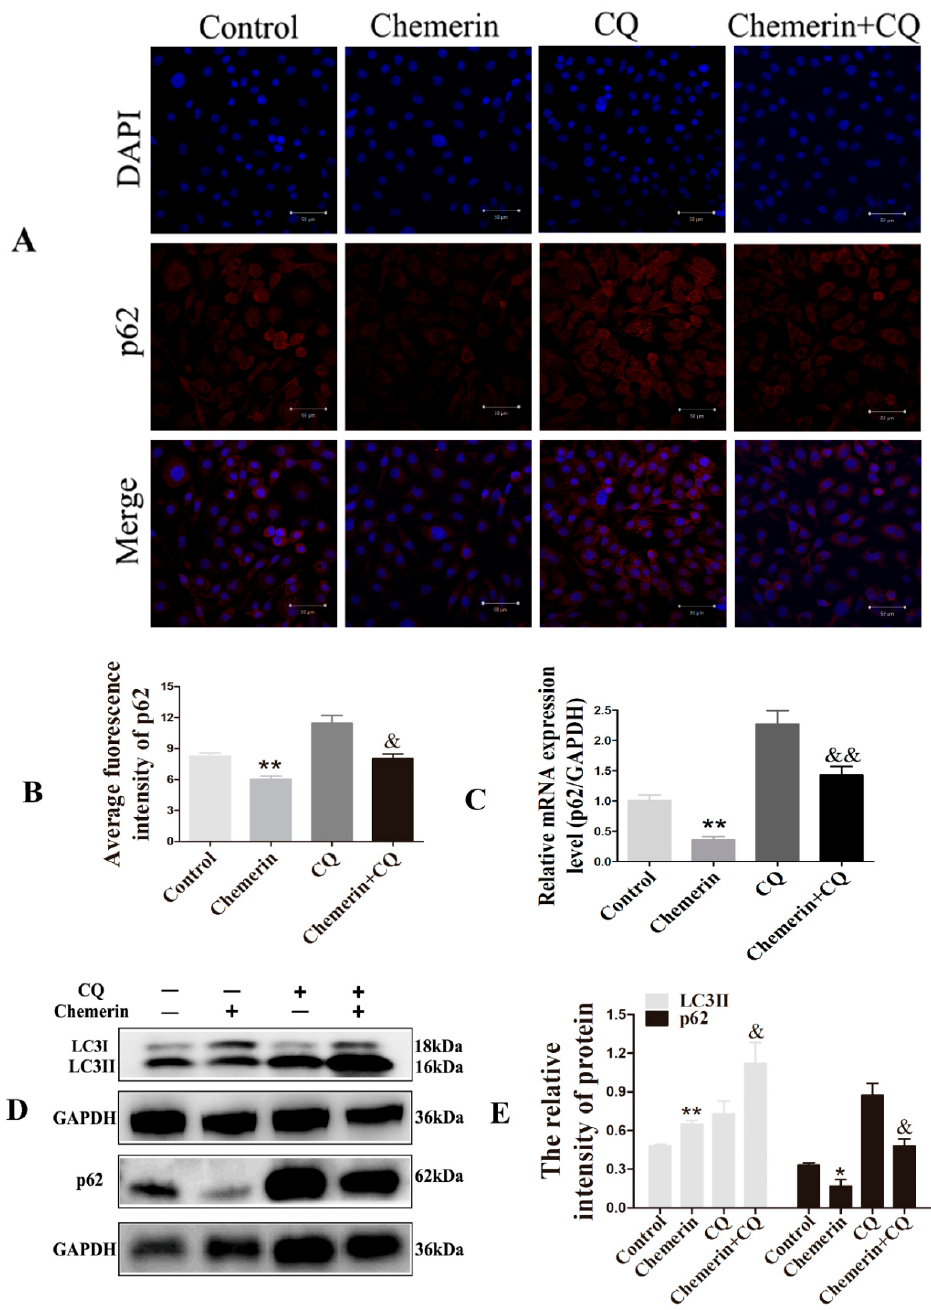
Figure 4. Chloroquine (CQ) inhibits Chemerin-induced autophagy in BMECs. The BMECs were treated with 10 µmol/L CQ for 2 h and then incubated with 0.1 µg/mL Chemerin for 24 h. ( A ) p62 protein expression was observed by confocal microscopy in different treatment groups. ( B ) The average fluorescence intensity of p62 was quantified in different treatment groups. ( C ) mRNA expression of p62 was detected by qRT-PCR in different treatment groups. The real-time PCR results were analyzed using a 2 − △△ ct model. ( D ) LC3 and p62 expression were analyzed by Western blot in different treatment groups. ( E ) Densitometric analysis of proteins in ( D ) by Image J software. All data are expressed as means ± SEM, with each treatment performed in triplicate. A single asterisk indicates a statistical difference ( p < 0.05), and a double asterisk indicates a statistically significant difference ( p < 0.01) when compared with the control. A single ampersand indicates a statistical difference ( p < 0.05), and a double ampersand indicates a statistical difference ( p < 0.01) when compared with the Chemerin-treatment group.